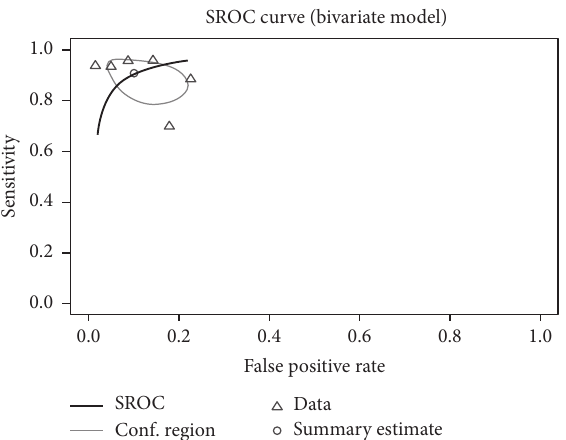
Figure 6: SROC curve of the Reitsma model with the summary estimated (circle) and its confidence interval